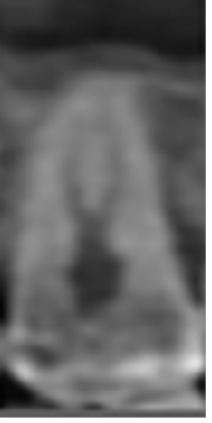
Figure 3. R—the removed teeth.